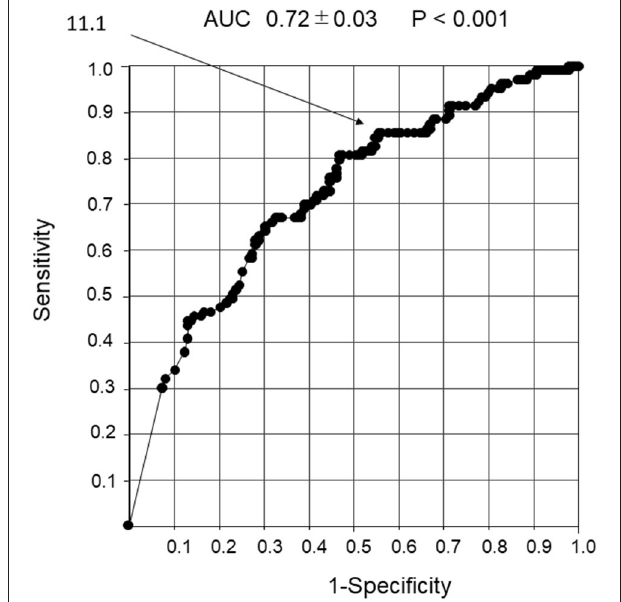
β 2-agonist inhalation with the number of wheeze power bands per 30s. Detection of non-response to inhaled β 2-agonist using the number of wheeze power bands per 30s. An ROC curve analysis was performed to determine the response to inhaled β 2-agonist with the number of wheeze power bands per 30s. The cutoff value for the number of wheeze power bands per 30s that could predict reactivity to the inhaled β 2-agonist was